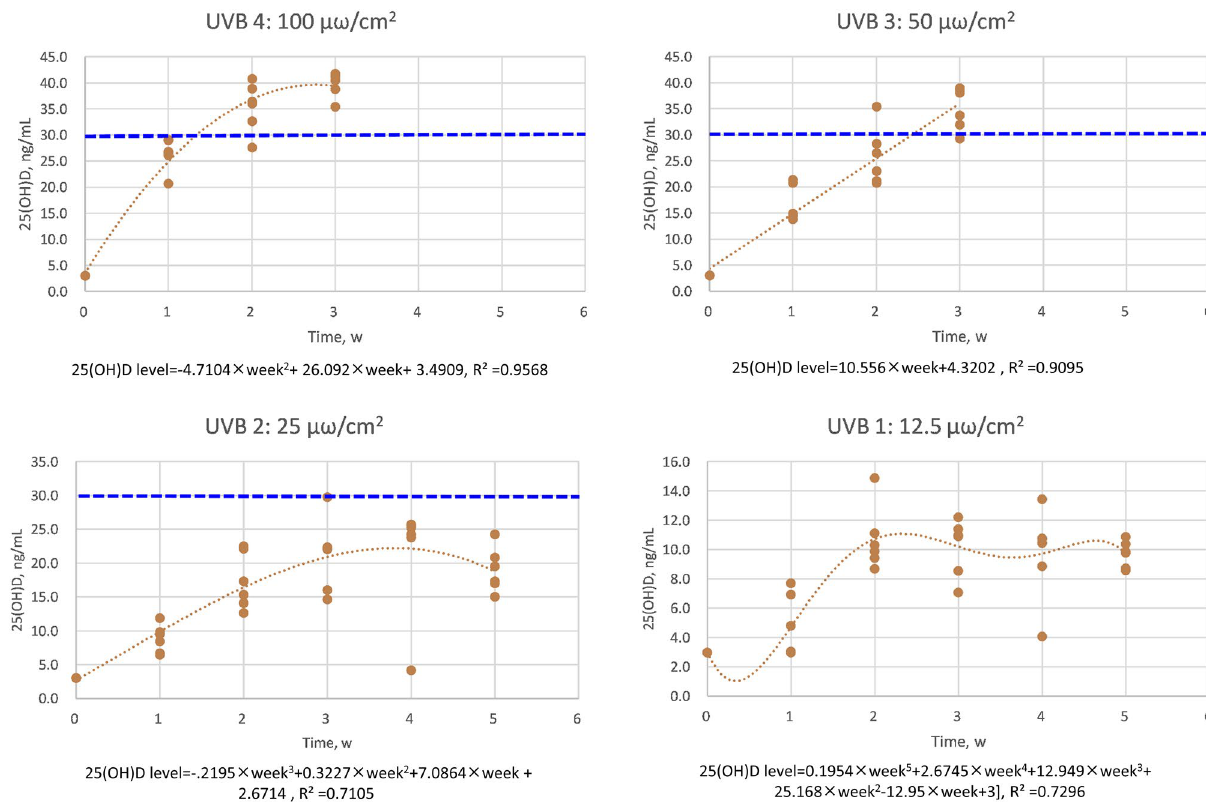
Figure 1. The distibution of 25(OH)D levels after 308 nm UVB irradiation in different exposure times according to dose. The optimal mathematical function to describe the associations between irradiation time and 25(OH)D level by different UBV irradiation dose was determined by maximal R square